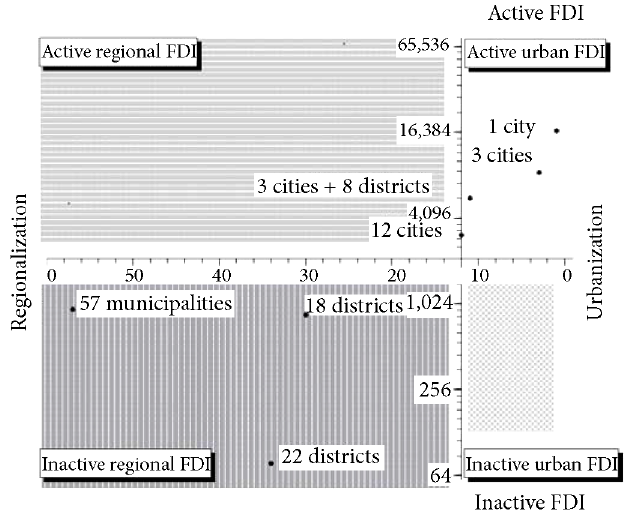
Figure 5. Future regional policy formation scenarios for Lithuanian municipalities (made by